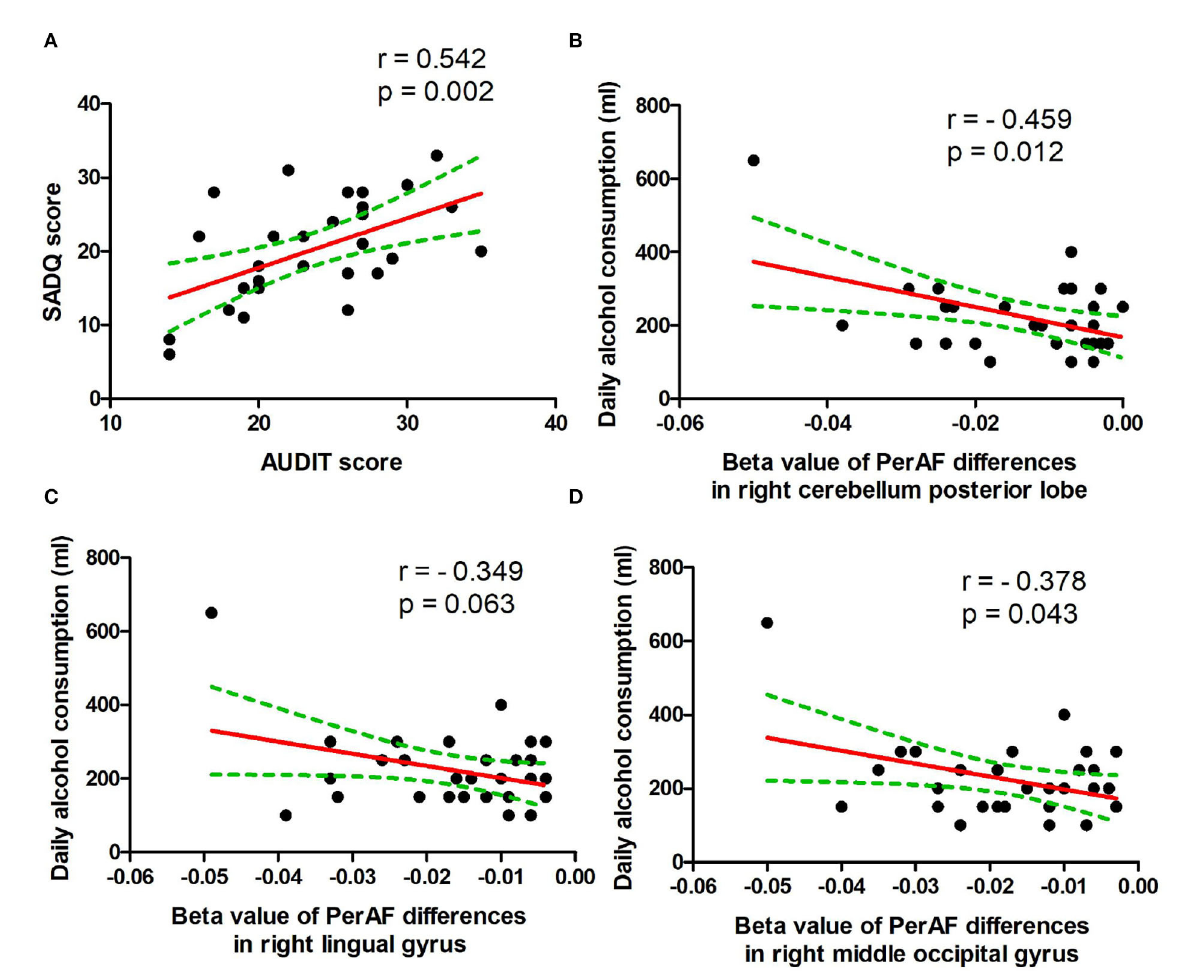
FIGURE5 Pearson’s correlation. (A) Correlation between SADQ and AUDIT, (B) correlation between daily alcohol consumption and right cerebellum posterior lobe, (C) correlation between daily alcohol consumption and right lingual gyrus, and (D) correlation between daily alcohol consumption and right middle occipital gyrus. SADQ, severity of alcohol dependence questionnaire; AUDIT, alcohol use disorders identification test; PerAF, percent amplitude of